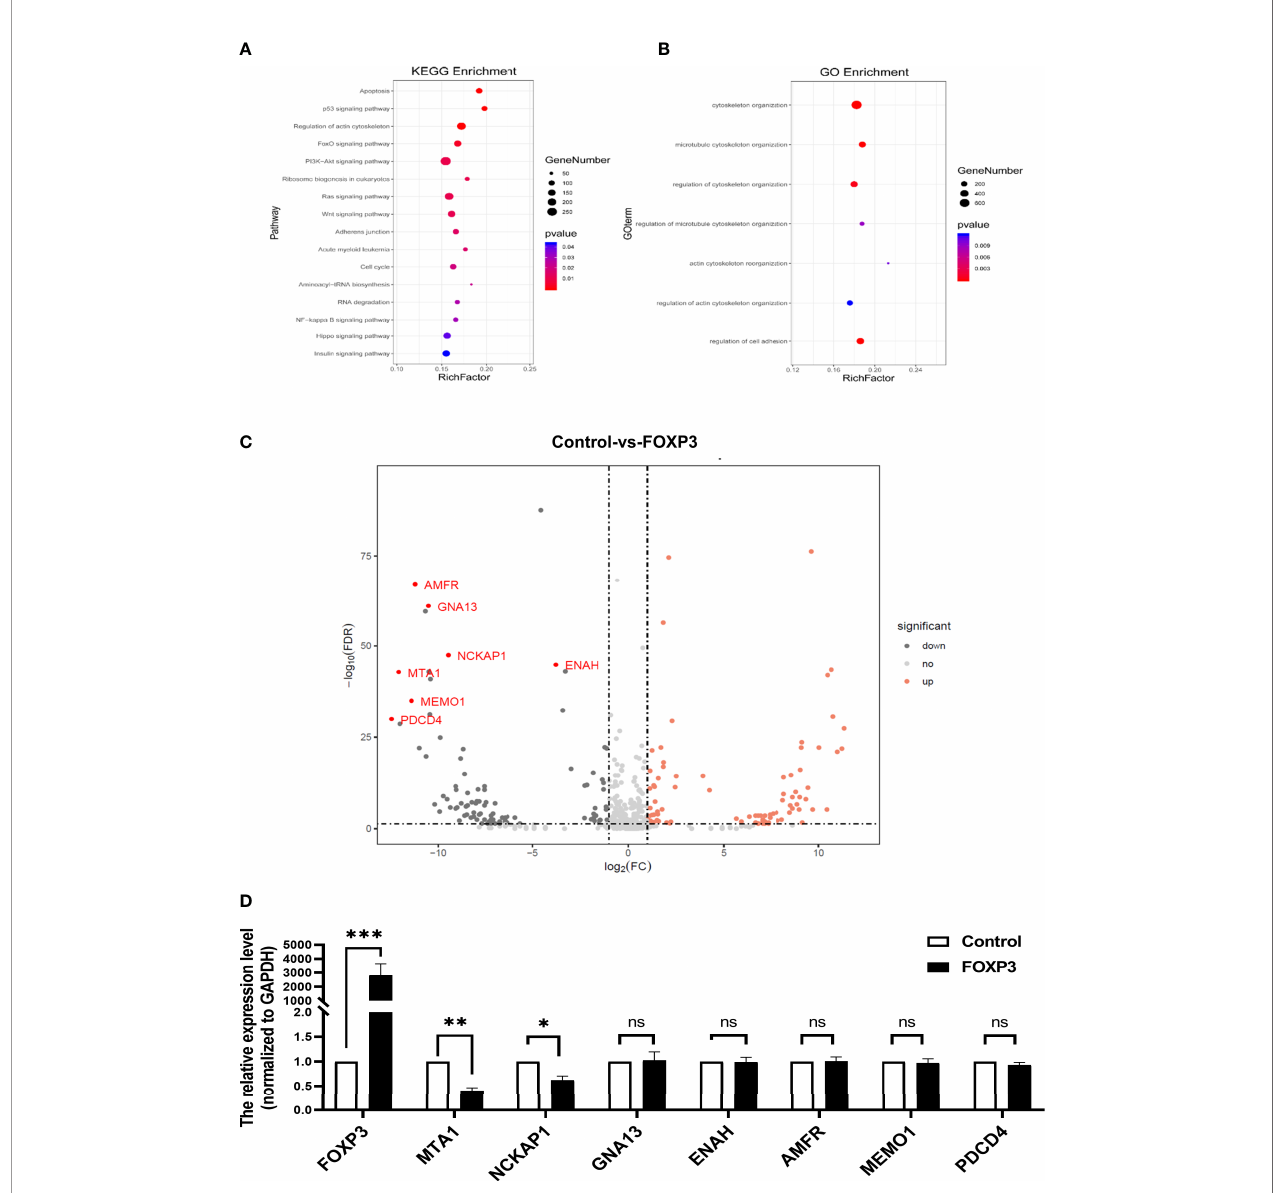
FIGURE 1 | MTA1 is a downstream molecule of FOXP3. (A) KEGG analysis showed that the target genes of FOXP3 might be involved in the regulation of cell movement and migration pathways. (B) GO analysis showed that the identi fi ed differentially expressed genes participate in cell adhesion and cytoskeletal reorganization. (C) Seven molecules were selected from the transcriptome sequencing results. (D) The mRNA expression levels of these 7 potential downstream molecules were determined by real-time PCR. The data are shown as the mean ± s.e.m. ns, P > 0.05; *P < 0.05; **P < 0.01; and ***P <